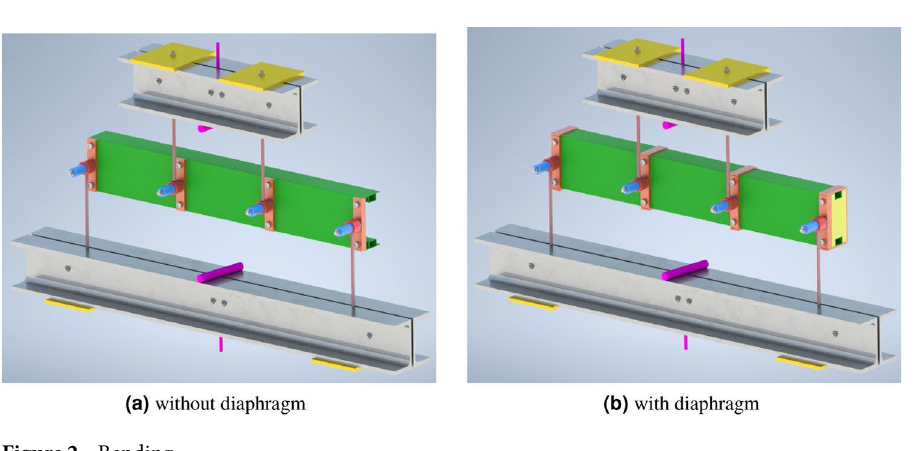
Figure 2. Bending.